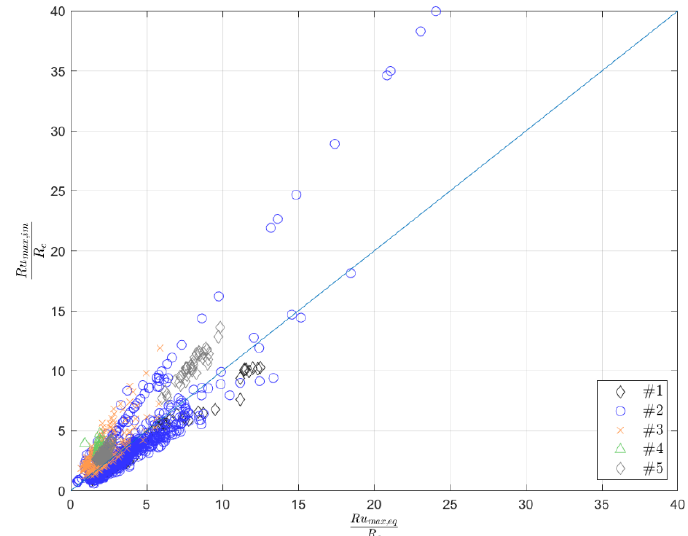
Figure 11. Comparison of dimensionless run-up values calculated with formulations proposed in EurOtop (2018) and Mase et al. (2013) and employing the equivalent ( Ru max, eq ) and imaginary slope ( Ru max, eq ), respectively.